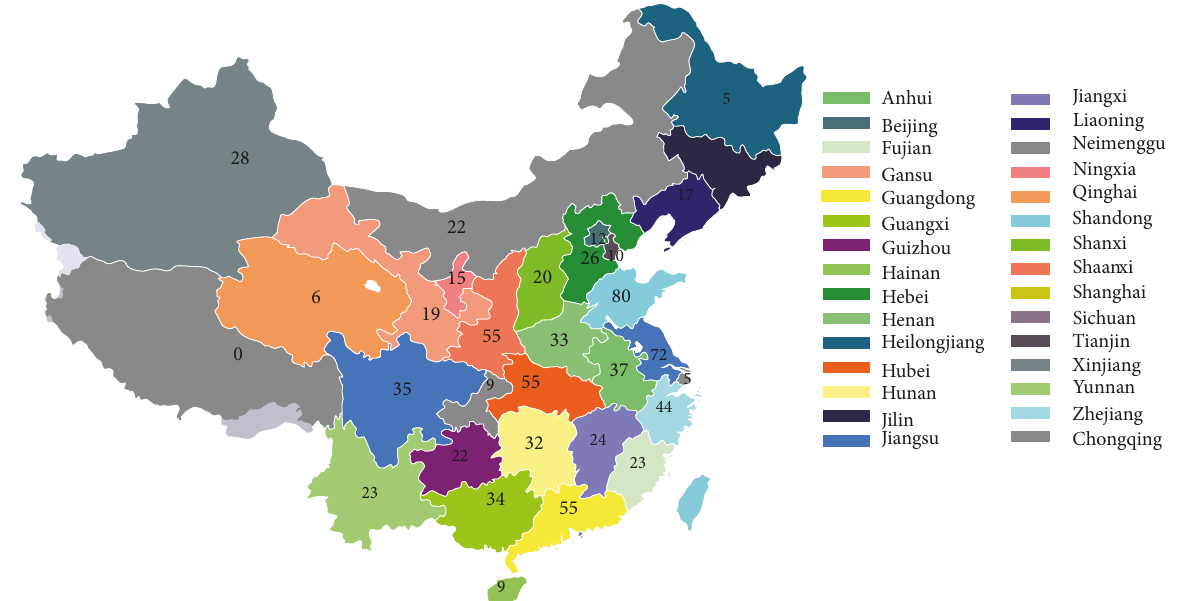
Figure 1: Regional distribution of